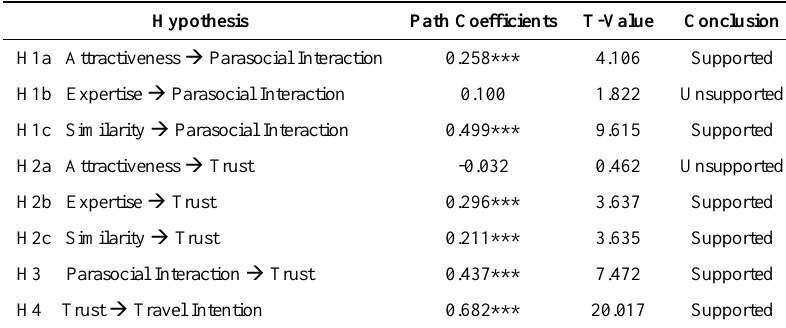
Table 8. Summary of Hypothesis